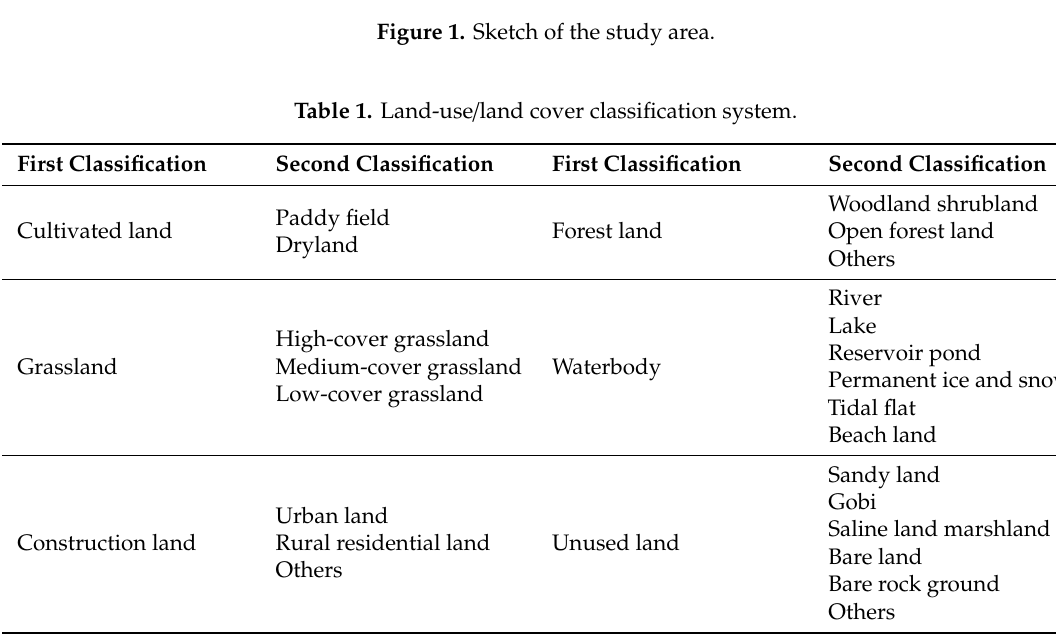
Table 1. Land-use/land cover classification system.